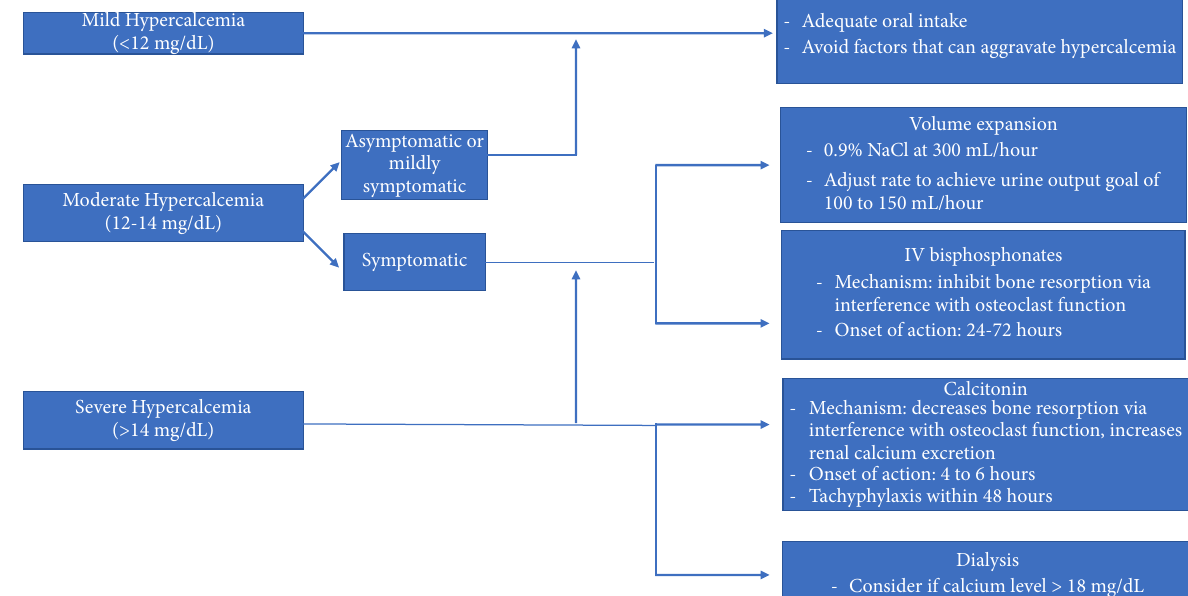
Figure 2: Treatment of